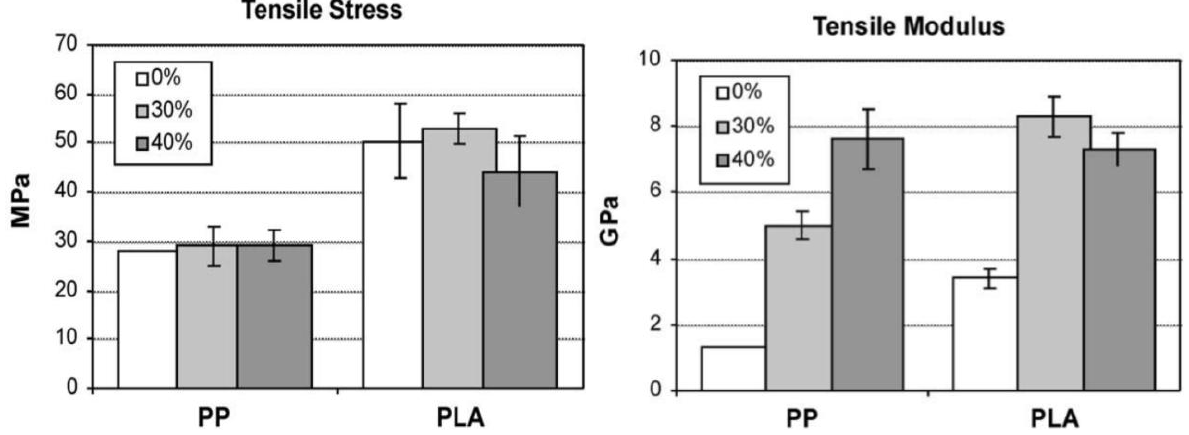
Figure 10. Tensile properties of flax/PLA compared to flax/PP composites. Adapted with permission from [87]. Copyright 2013 by